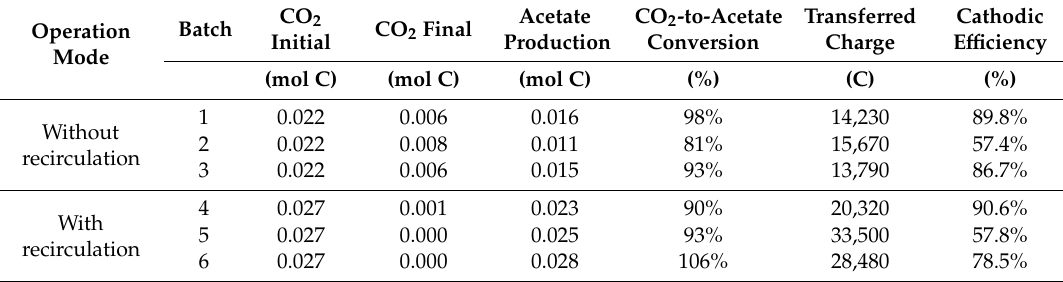
Table 2. Carbon balance and cathodic e ffi ciency. Averages between both MES replicate reactors (MES1 and MES2) are